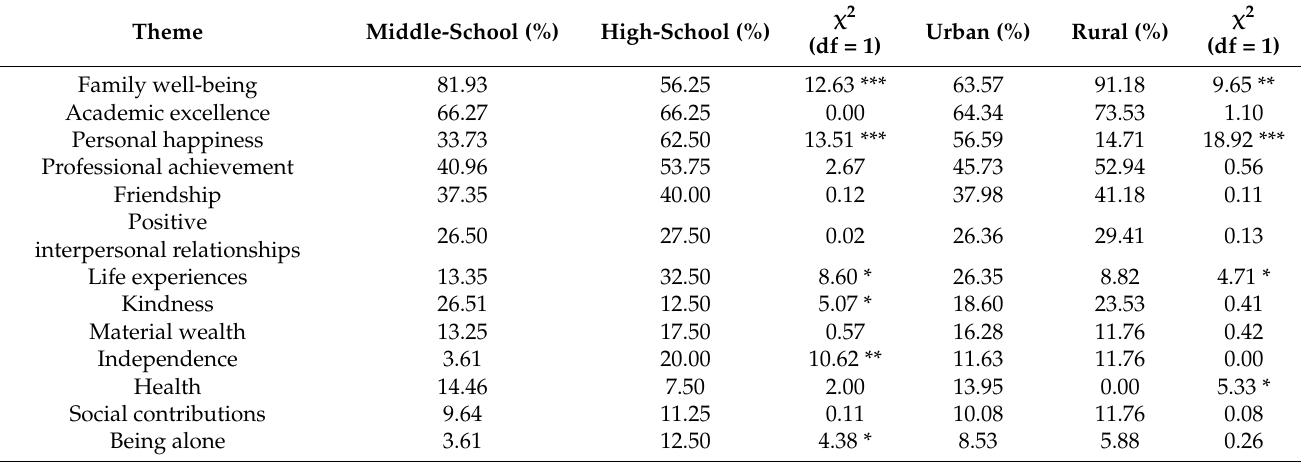
Table 2. Grade and Urban-Rural Differences in Adolescents’ Endorsement of Each